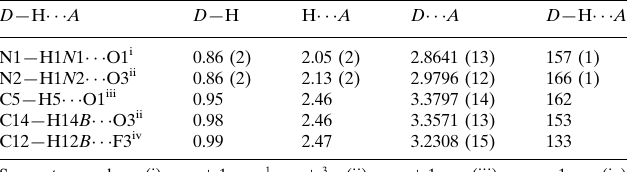
Hydrogen-bond geometry (A ˚ , (cid:3)